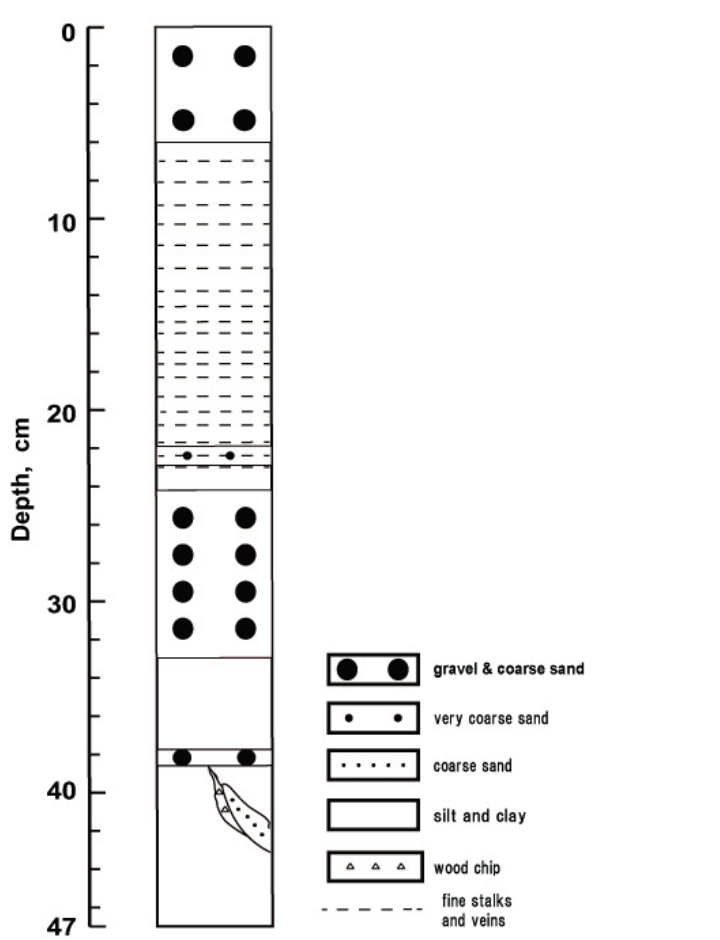
Fig. 4 Stratigraphy of the sediment core